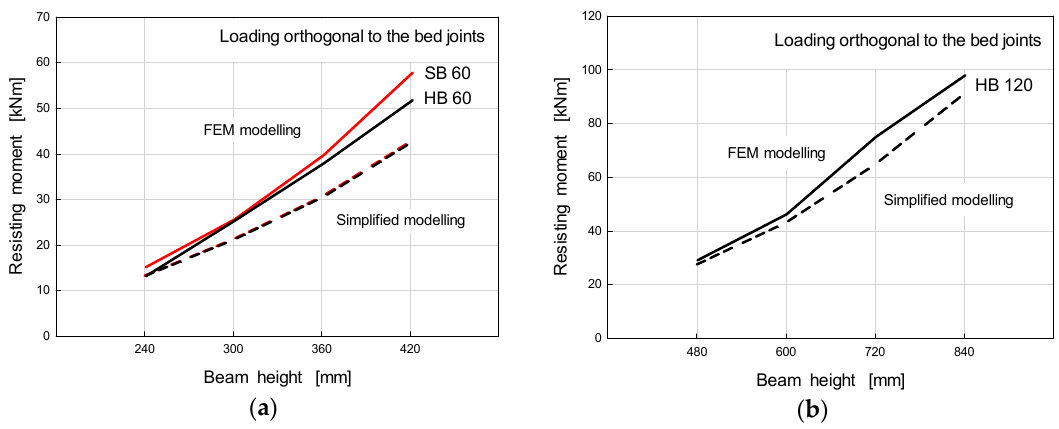
Figure 7. Resisting bending moments of masonry beams reinforced by flax fibers for loads orthogonal to the bed joints: ( a ) solid and hollow bricks 60 mm thick; ( b ) hollow bricks 120 mm thick.